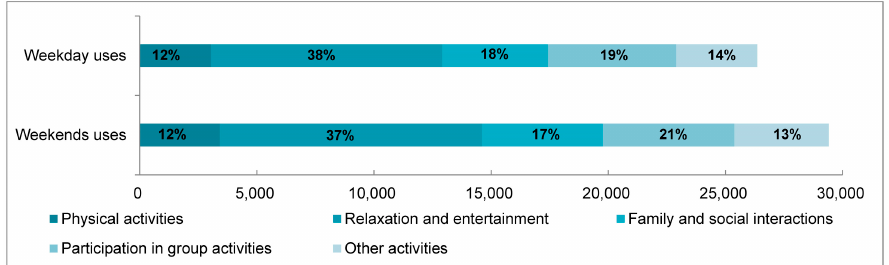
Figure 4. Distribution of the five pocket park use categories on weekdays and weekends.